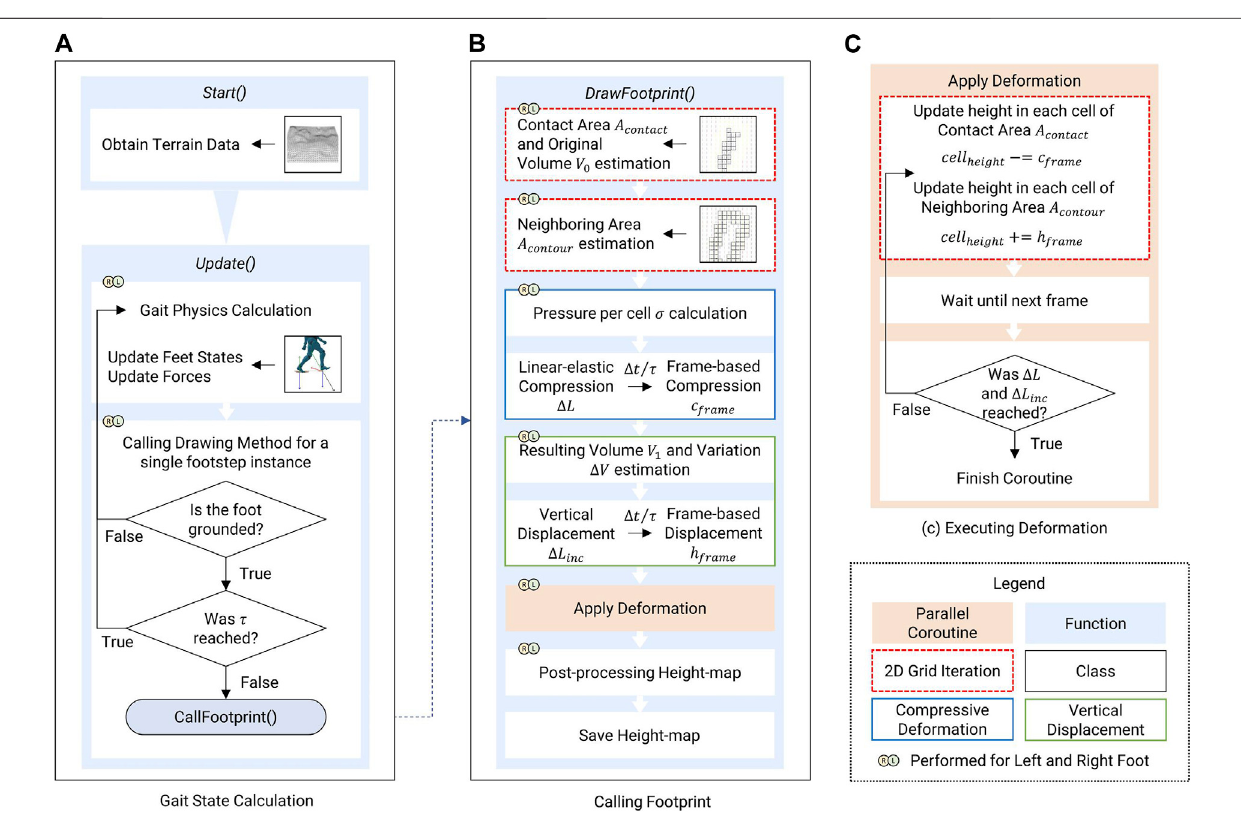
Frontiers in Virtual Reality |